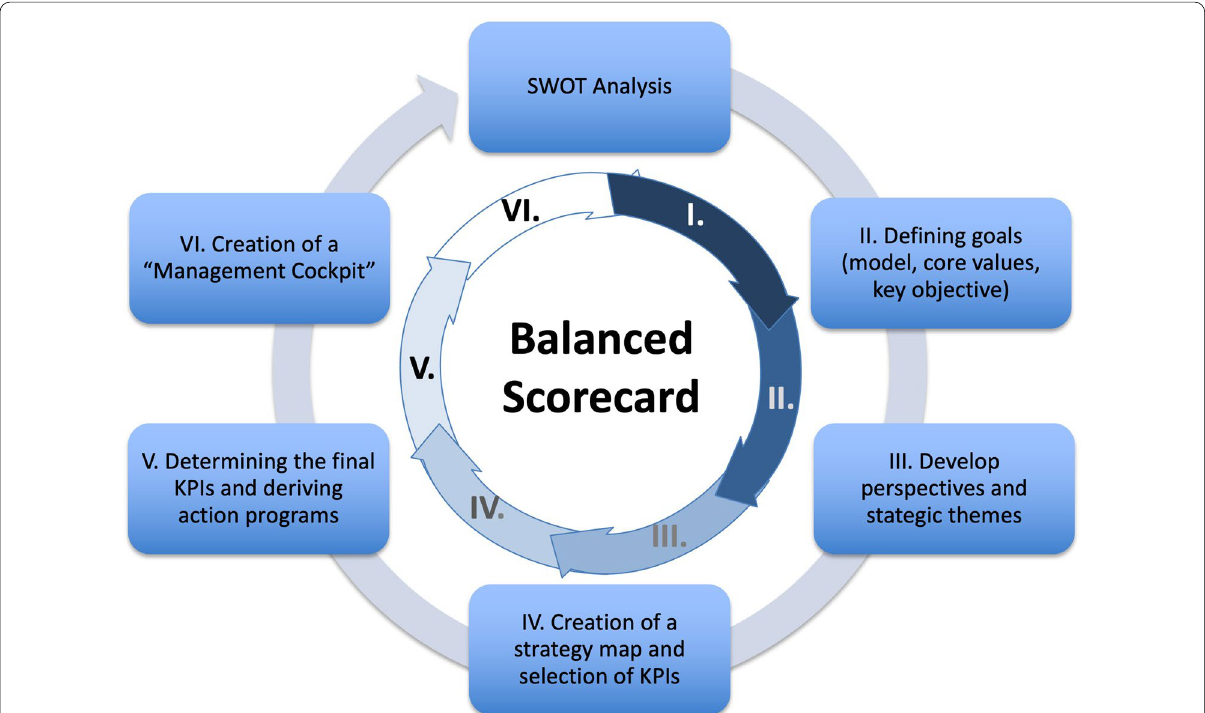
Fig. 2 Process steps to create a balanced scorecard for the radiology